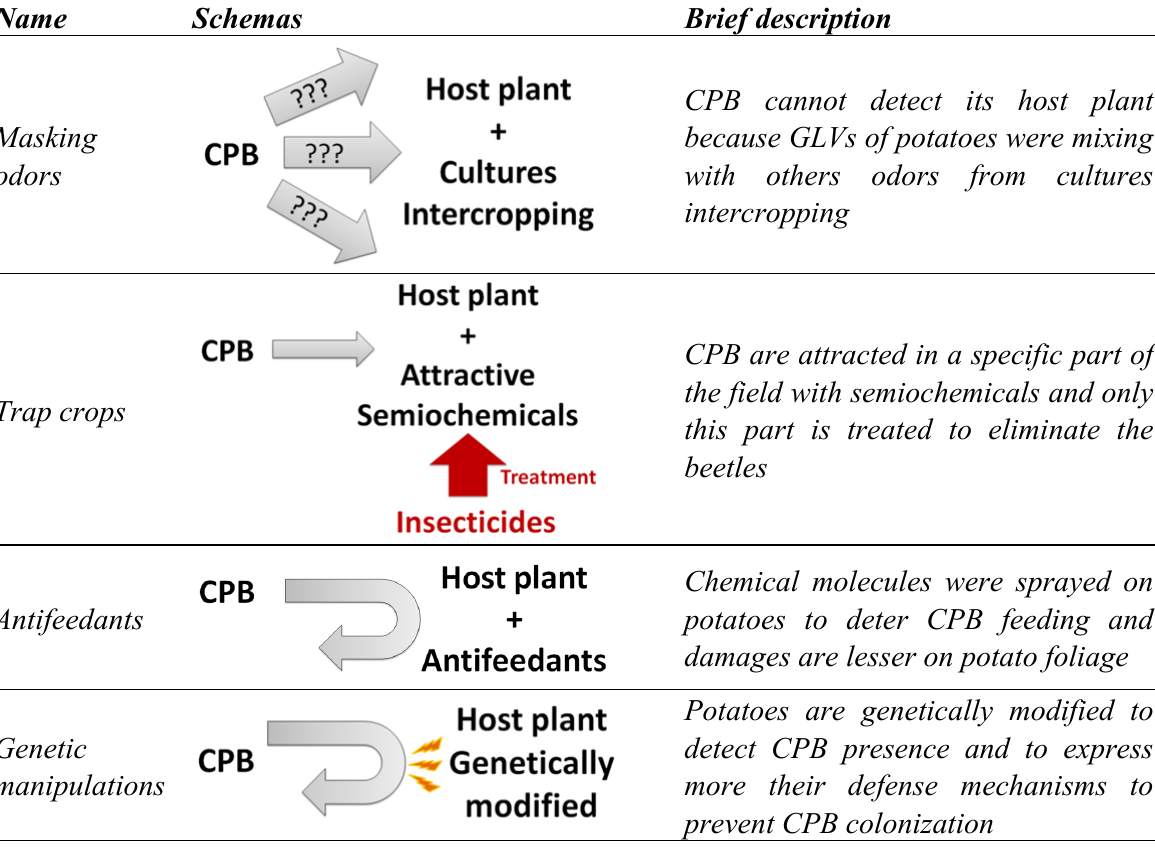
Table 2. Different approaches suggested to control the Colorado potato